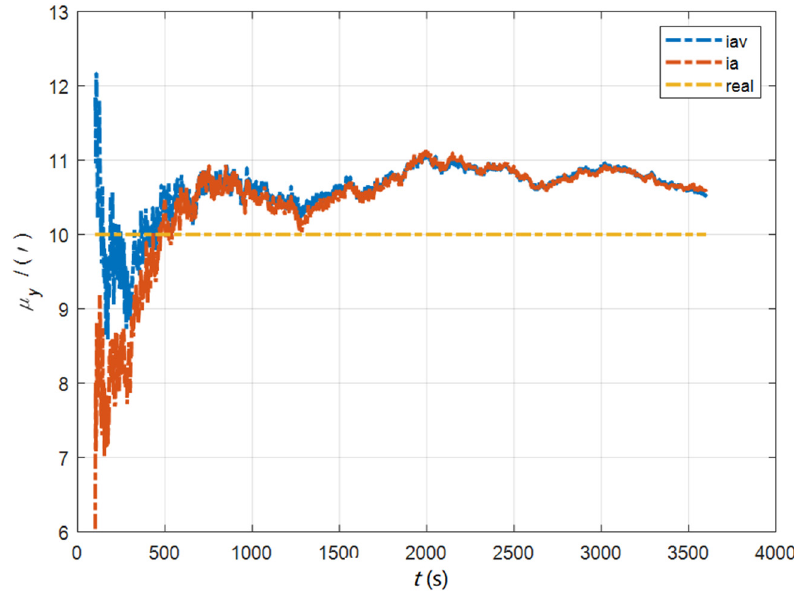
(cid:48) 0.5 (cid:48) 10 (cid:48) ] T . ′ . Figure 14. The curves of µ y in the cases of the initial misalignment angles [ 0.5